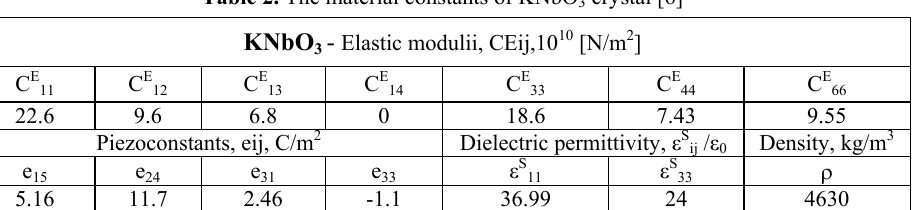
Table 2. The material constants of KNbO 3 crystal